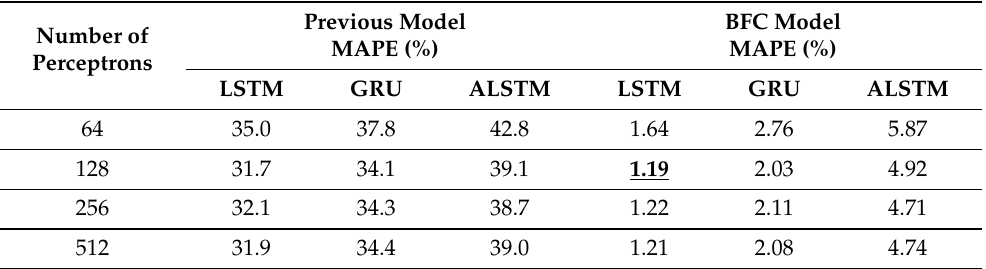
Table 4. Performance of BFC-based models against previous non-BFC-based methods in terms of the number of perceptrons in the neural networks.